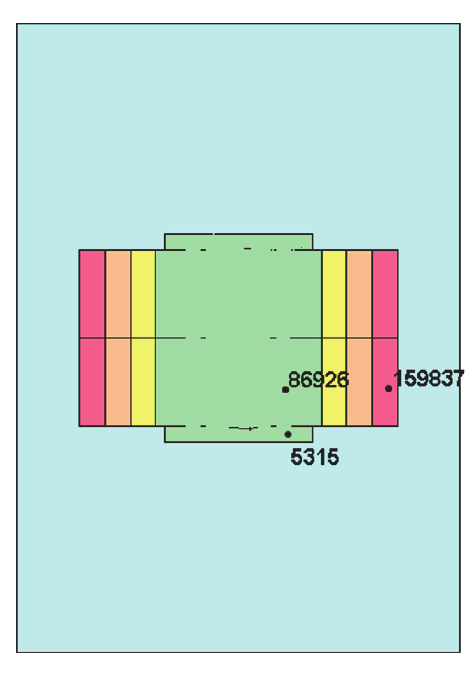
Figure 11: Location of typical